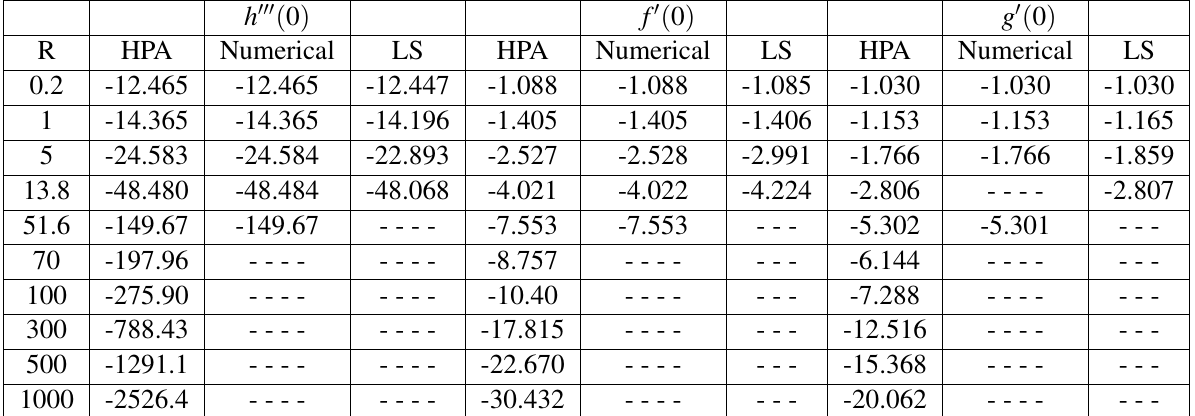
Table 3 Comparison of the Homotopy pade approximations (HPA) [40, 40] solution with the numerical solution [2] and long series (LS) [16] for different values of the Reynolds number R